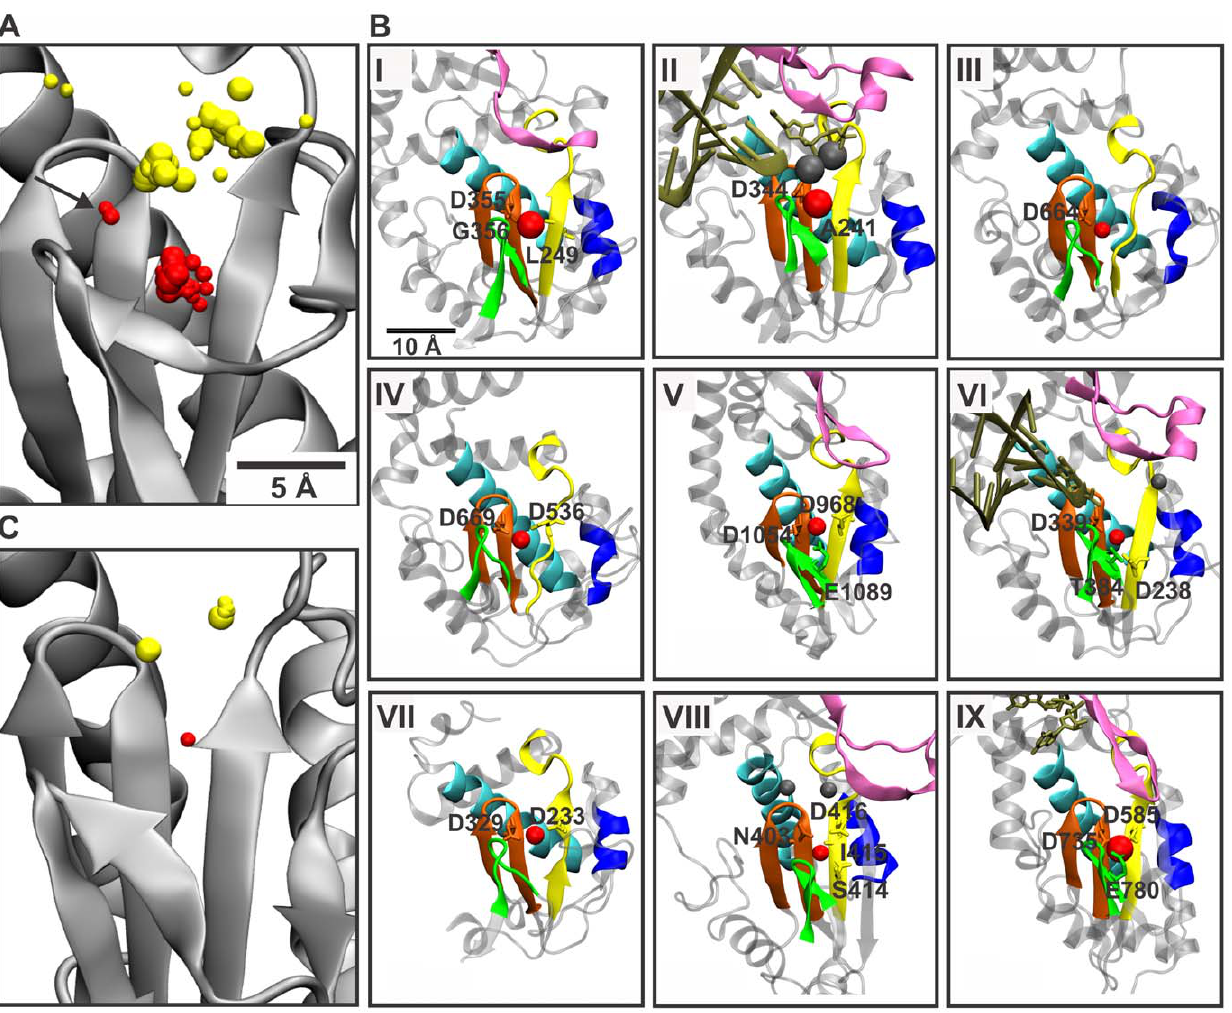
Figure 2. Non-catalytic and catalytic ions in vRdRps. (A) Structural alignment of vRdRps with bound cations. The catalytic site of the w 6 RdRp (PDBid: 1HHS) polypeptide is depicted with cations from all vRdRp structures. The catalytic ions are colored yellow, and the proposed non-catalytic ions are depicted as red (A and C). The size of the spheres depends on the type of the metal ion ligand. The arrow indicates the position of the non- catalytic ion in the enterobacteria phage Q b RdRp structures. (B) Magnified views of the catalytic site from selected viral RdRp structures with bound divalent cations. The vRdRp motifs are colored as in Figure 1. Template nucleic acids and nucleotides are shown in tan. Non-catalytic ions are shown as red spheres, and catalytic ions are shown as gray spheres. The amino acids involved in the coordination of the bound non-catalytic ion are indicated. RdRp of (I) rabbit hemorrhagic virus with a Lu 2 + ion (PDBid: 1KHV); (II) Norwalk virus with three Mn 2 + ions (PDBid: 3H5Y); (III) Dengue virus with a Mg 2 + ion (PDBid: 2J7U); (IV) West Nile virus with a Ca 2 + ion (PDBid: 2HCN); (V) enterobacteria phage Q b with a Ca 2 + ion (PDBid: 3AGP); (VI) foot- and-mouth disease virus with three Mg 2 + ions (PDBid: 2E9T); (VII) poliovirus with a Ca 2 + ion (PDBid: 1RDR); (VIII) infectious bursal disease virus with three Mg 2 + ions (PDBid: 2R72); and (IX) mammalian orthoreovirus 3 with a Mn 2 + ion (PDBid: 1MWH). (C) The catalytic site of the HIV RT structure 1N6Q with cations from all HIV RT structures. The molecules were visualized using program VMD 1.8.7 [30].